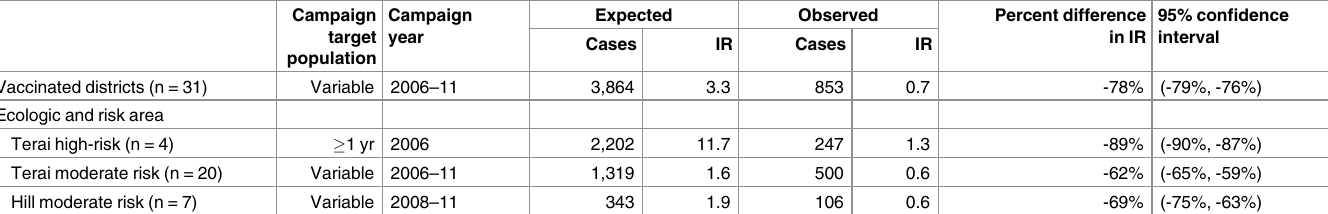
Table 1. Japanese encephalitis expected and observed cases and incidence rates (IR) per 100,000person yearsin Nepal.